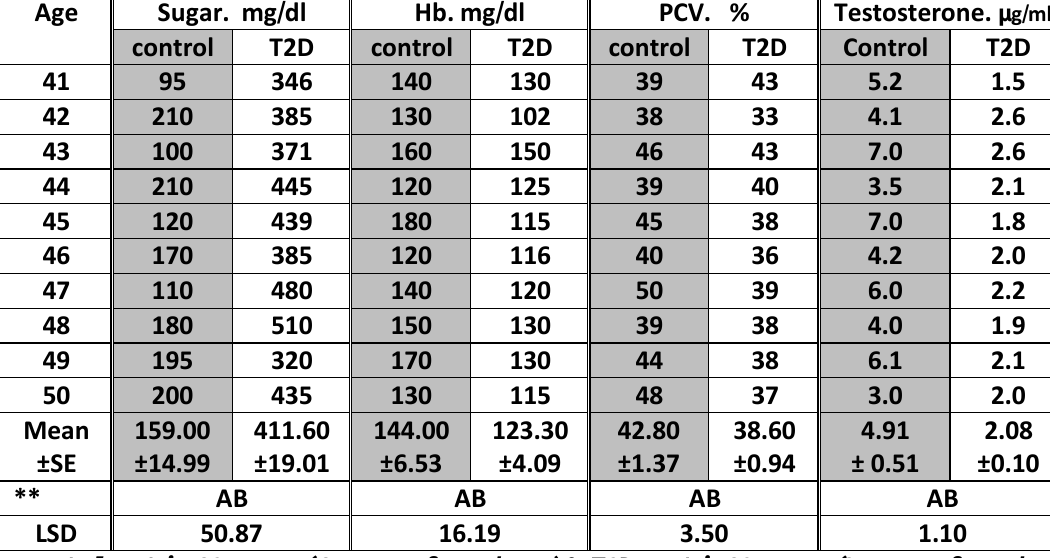
Table (2):Group B: age{41-50} years: Sugar , PCV, Hb & Testosterone level in both (control and T2D) *